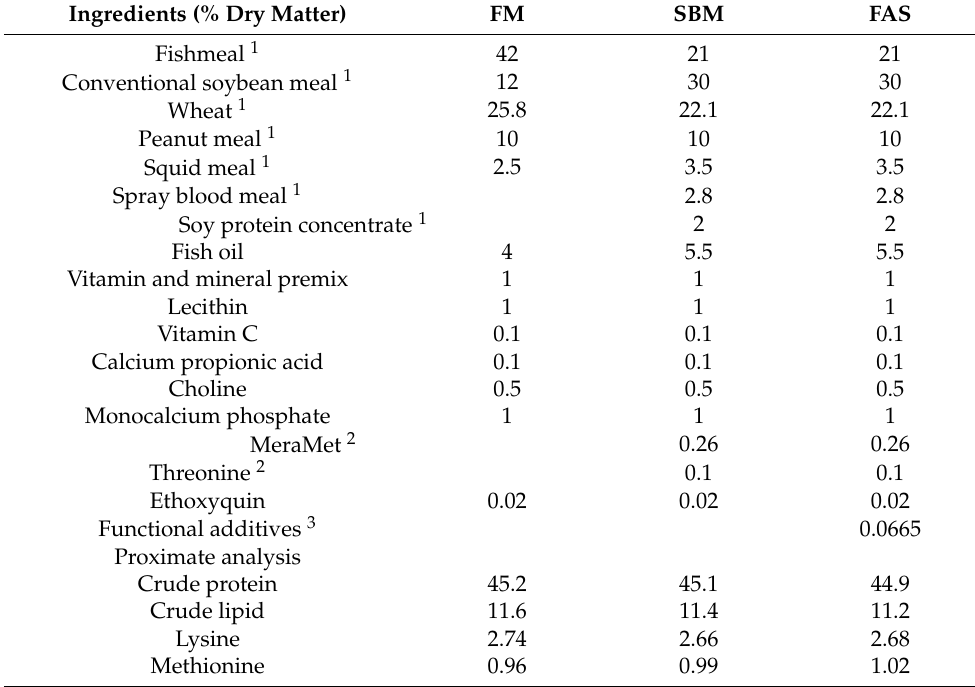
Table 1. Formulation and nutrient composition of the experimental